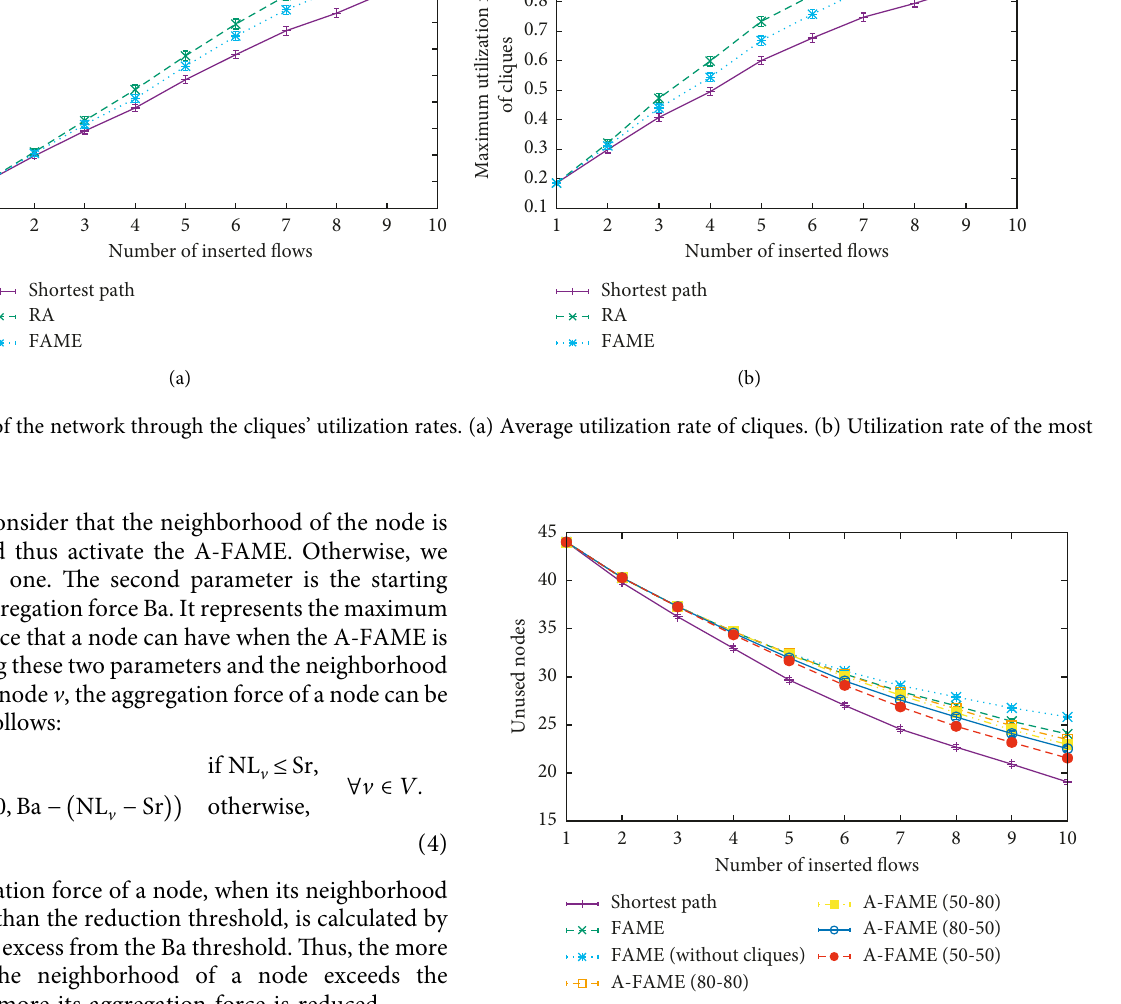
Figure 9: Number of unused nodes with various parameters for the